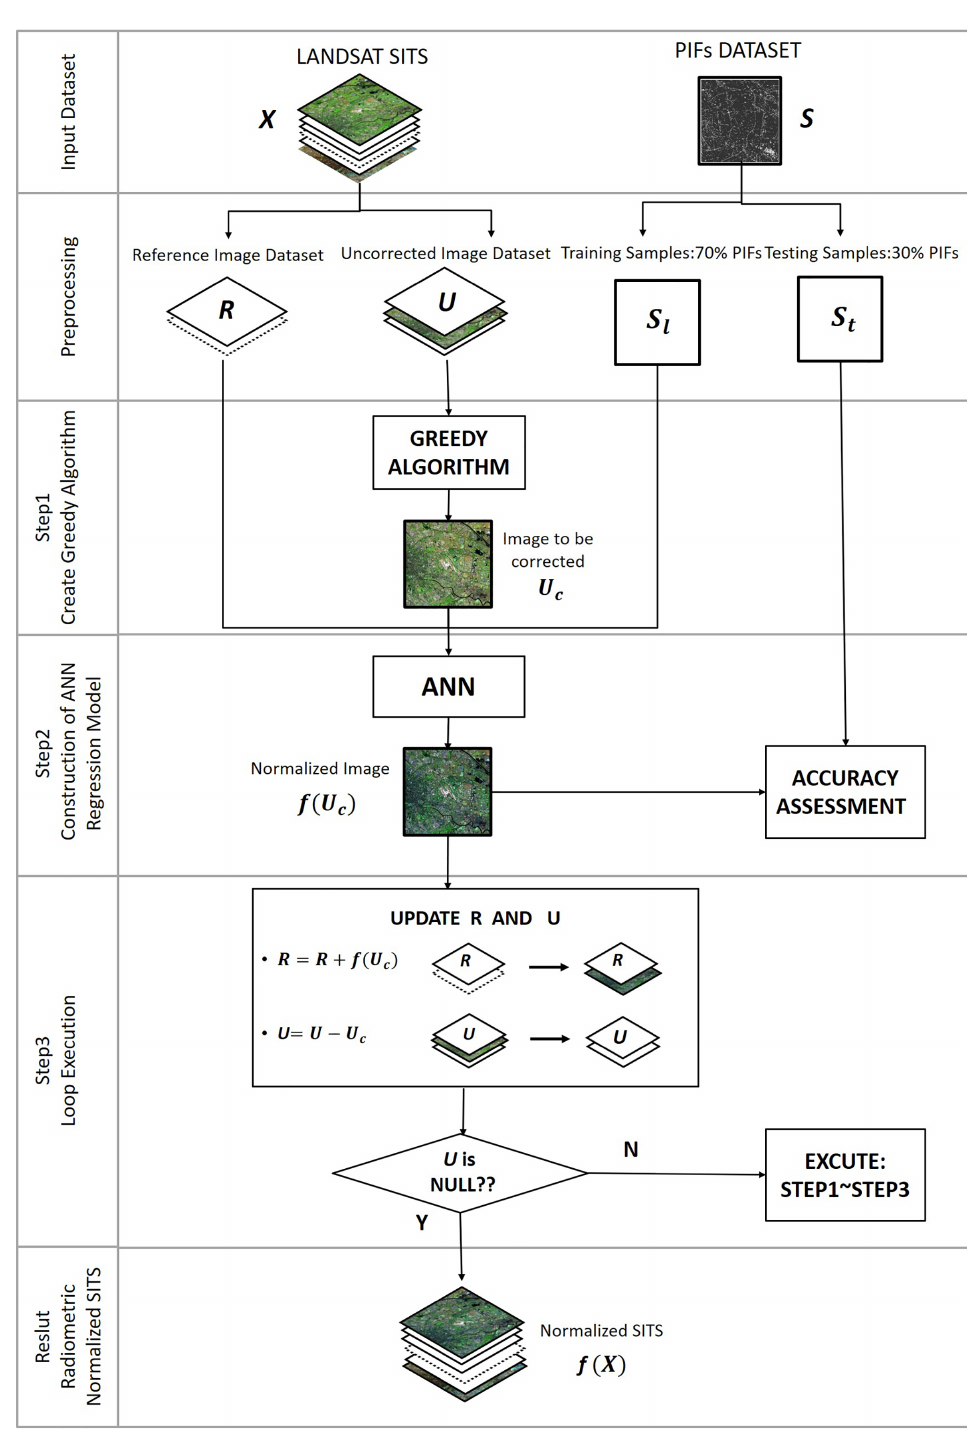
Figure 1. Flow diagram showing steps used by the proposed nonlinear radiometric normalization (NMAG) model for rediometric normalization of Satellite Image Time Series